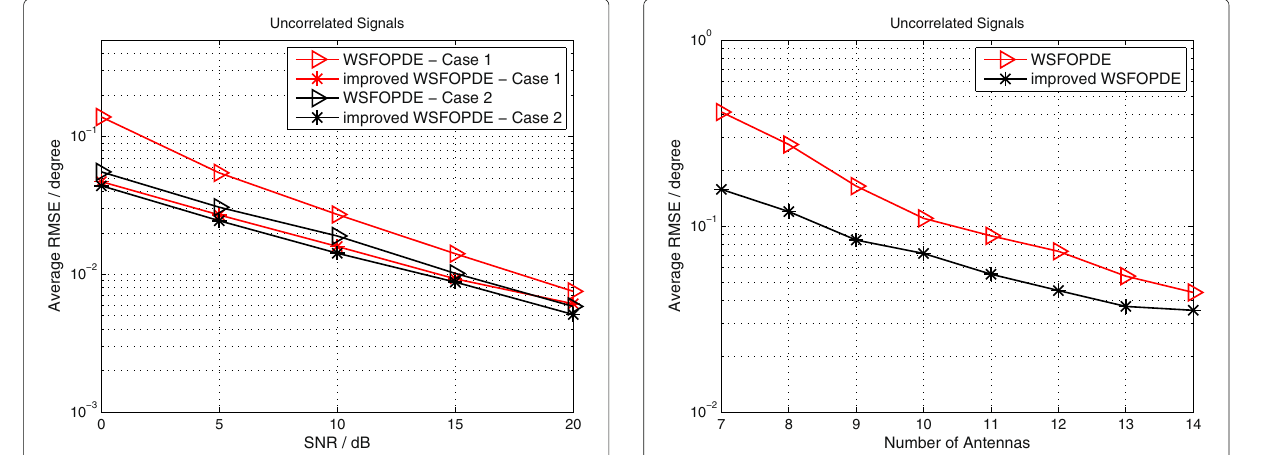
Fig. 7 The RMSE performance variation under different sub-signals number in one group of coherent signals: uncorrelated signals